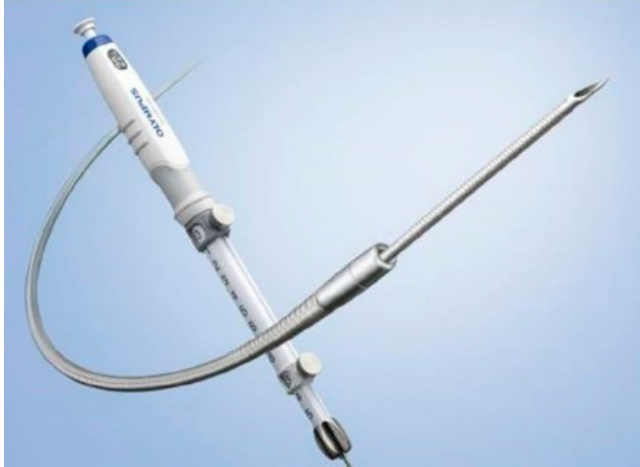
Figure 2. The EZshot3 plus (Olympus Medical Japan, Tokyo, Japan).